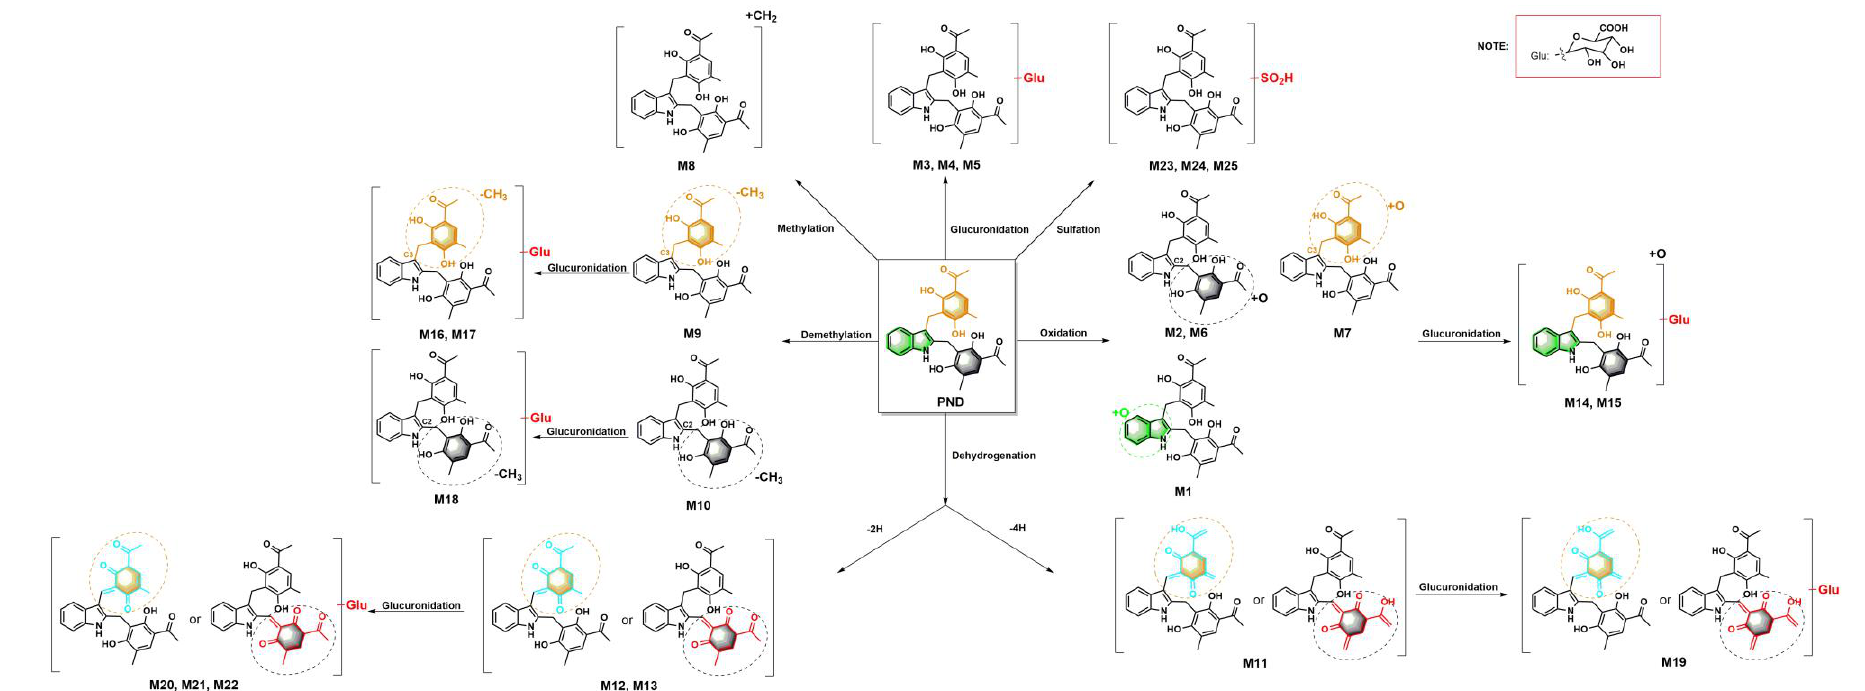
Figure 3. Proposed pathways for the metabolism of PND in rats after single administration.